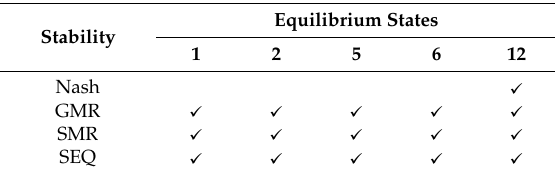
Table 11. Equilibrium states of the Changzhou conflict.